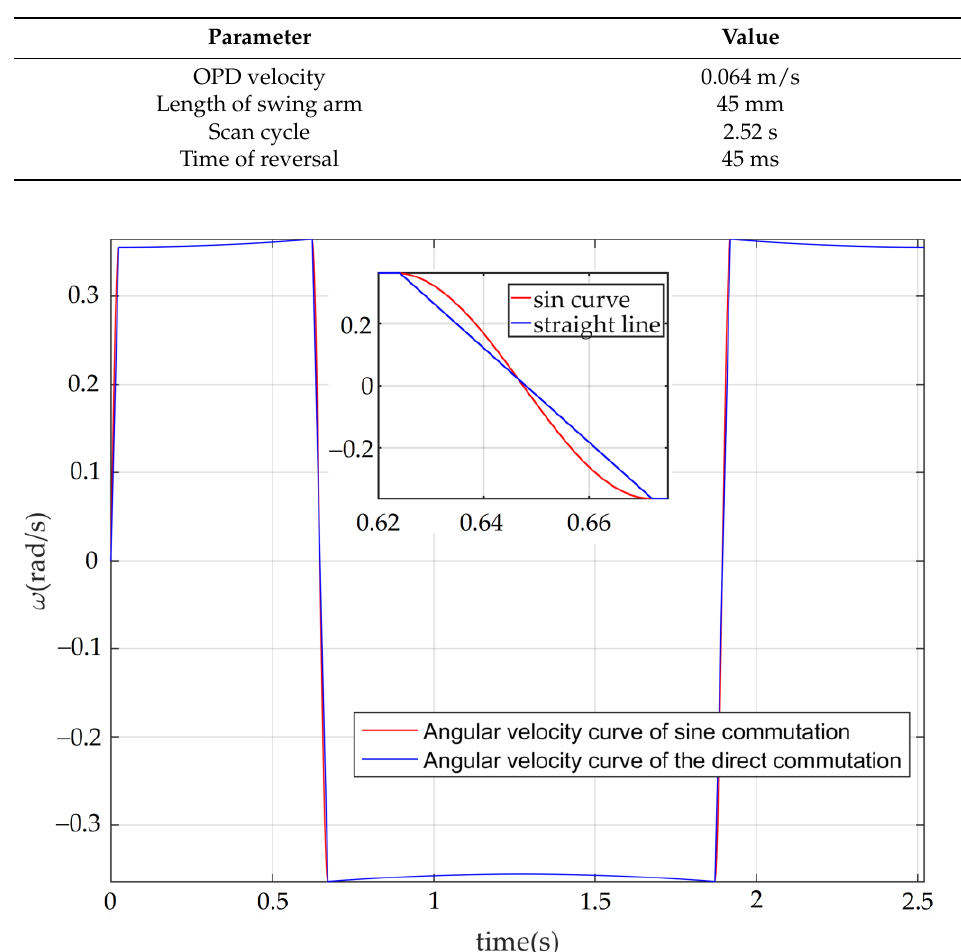
Figure 4. The relationship between the angular velocity and the time of the RT VCM.